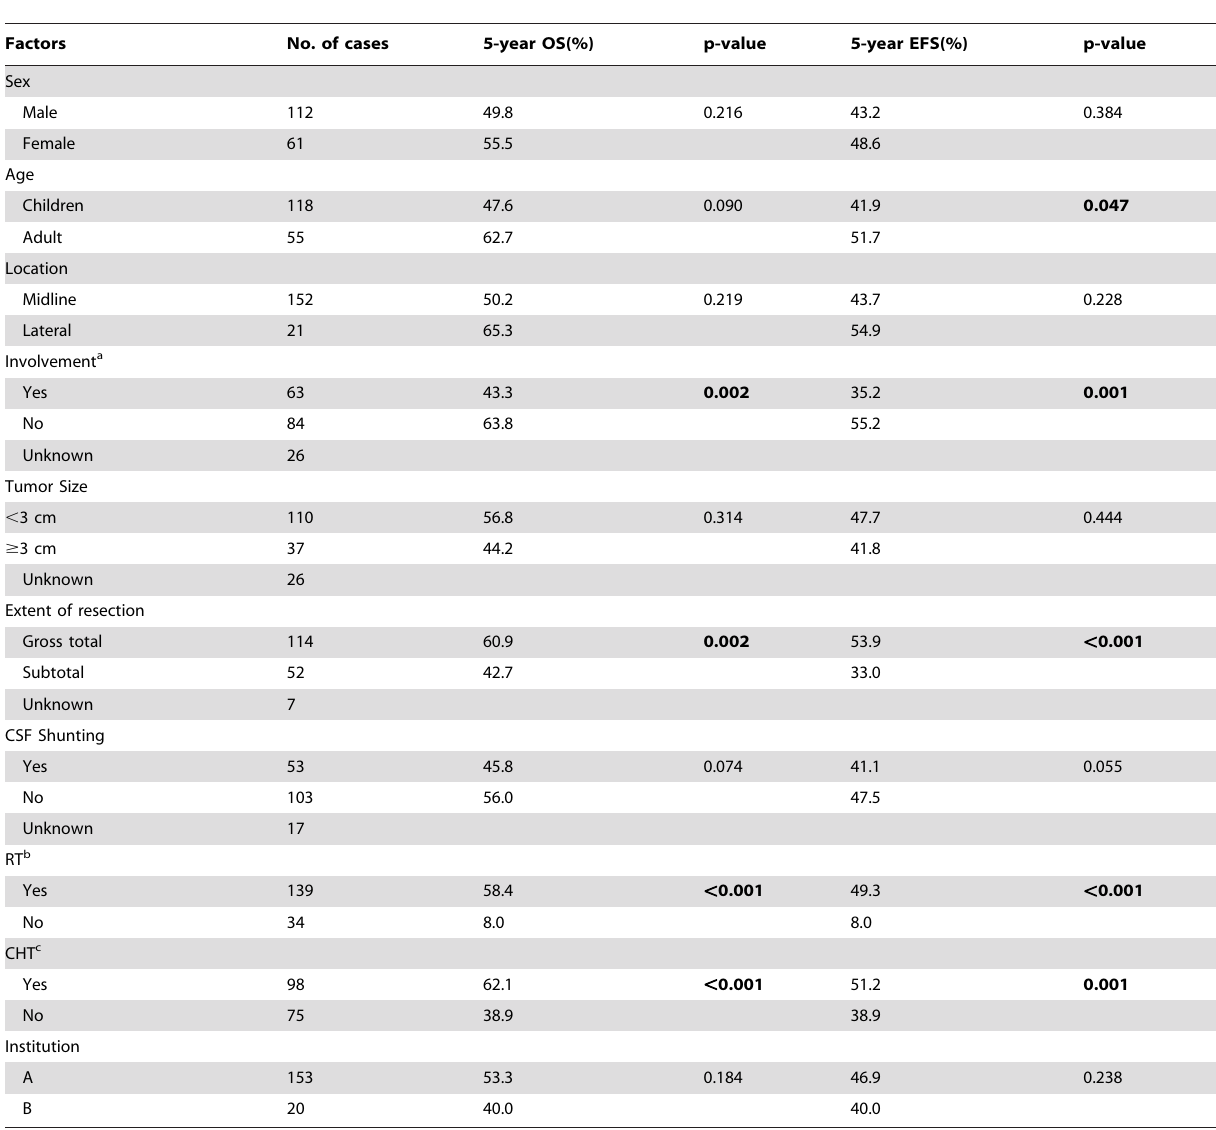
Table 1. Univariate analysis of prognostic factors for OS and EFS in medulloblastoma patients (n= 173).